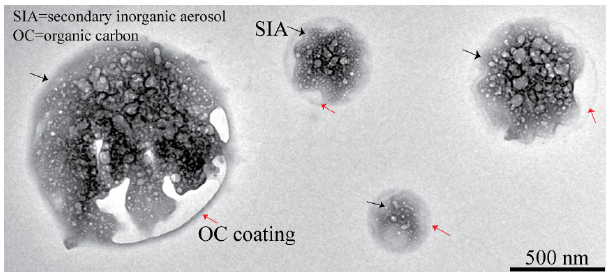
Figure 6. TEM image of individual particles collected in the clean period with PM 2 . 5 mass concentration less than 10µgm − 3 . SIA particles tend to homogeneously mix with